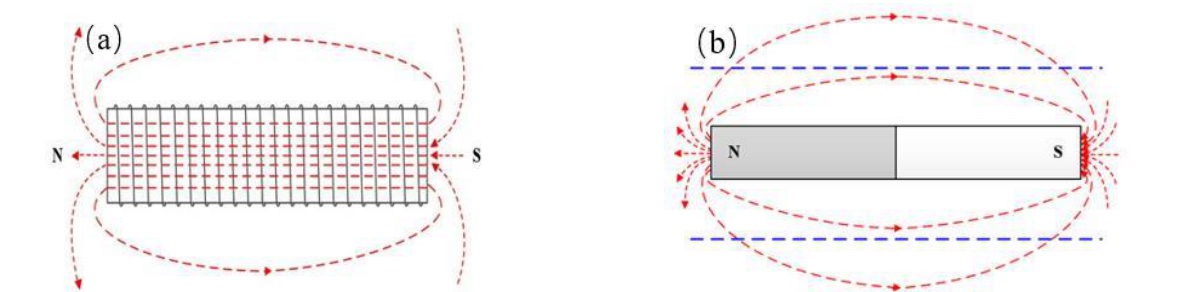
Figure 1. Distribution of magnetic lines. ( a ) Solenoid; ( b ) bar magnets.